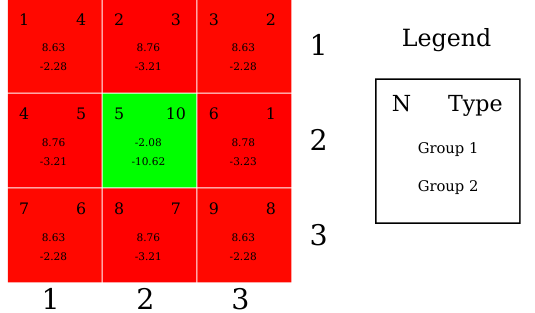
Figure 7. 2D flux differences for each part of the test case in CASE6_COR and enrichment